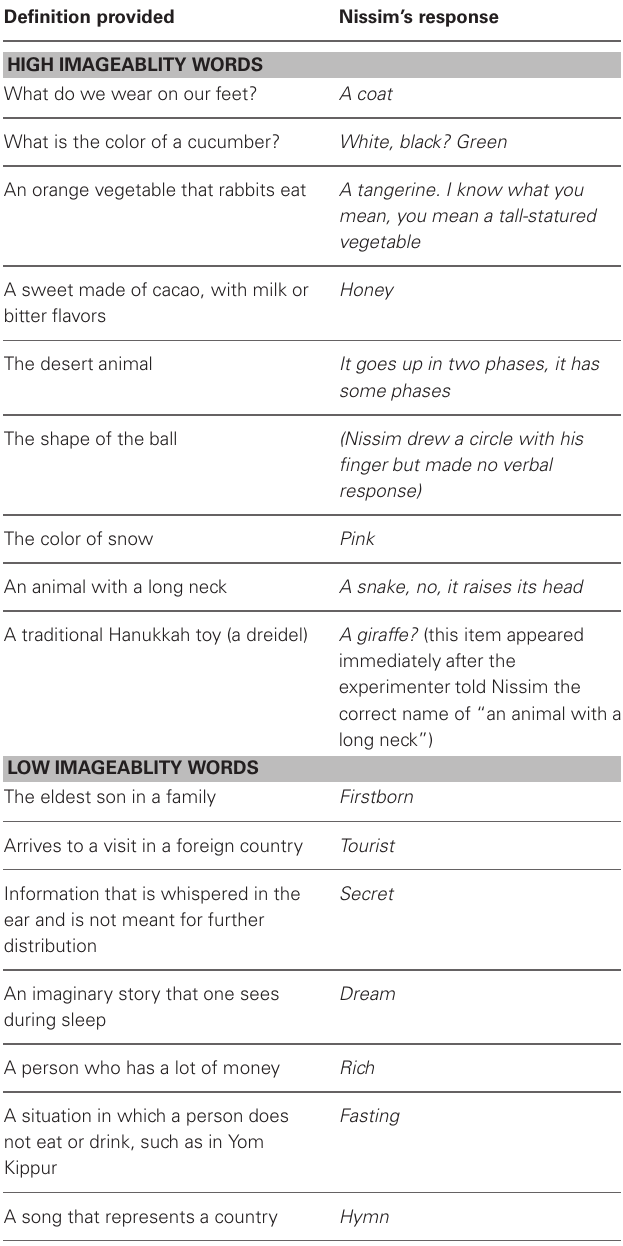
Table 2 | Examples of Nissim’s responses in the naming to definition task: high and low imageability